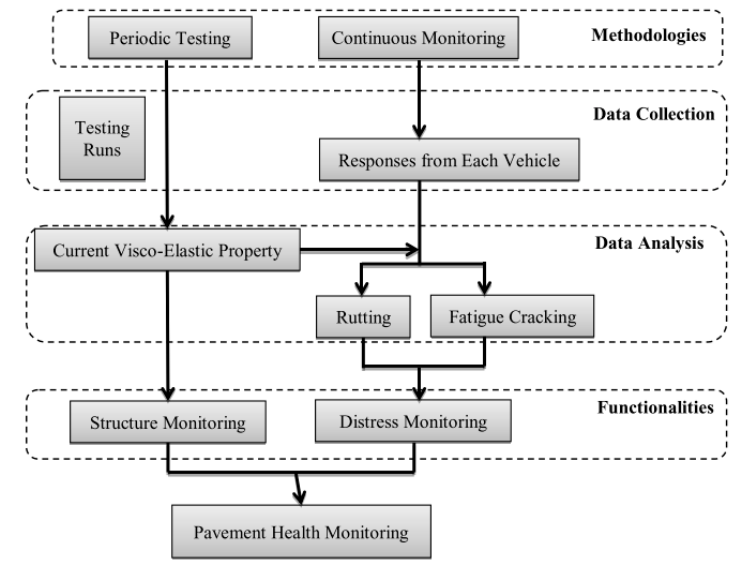
Figure 11. Pavement monitoring system designed for Route 114 in Christiansburg (figure is reproduced from Wang et al. [39]).